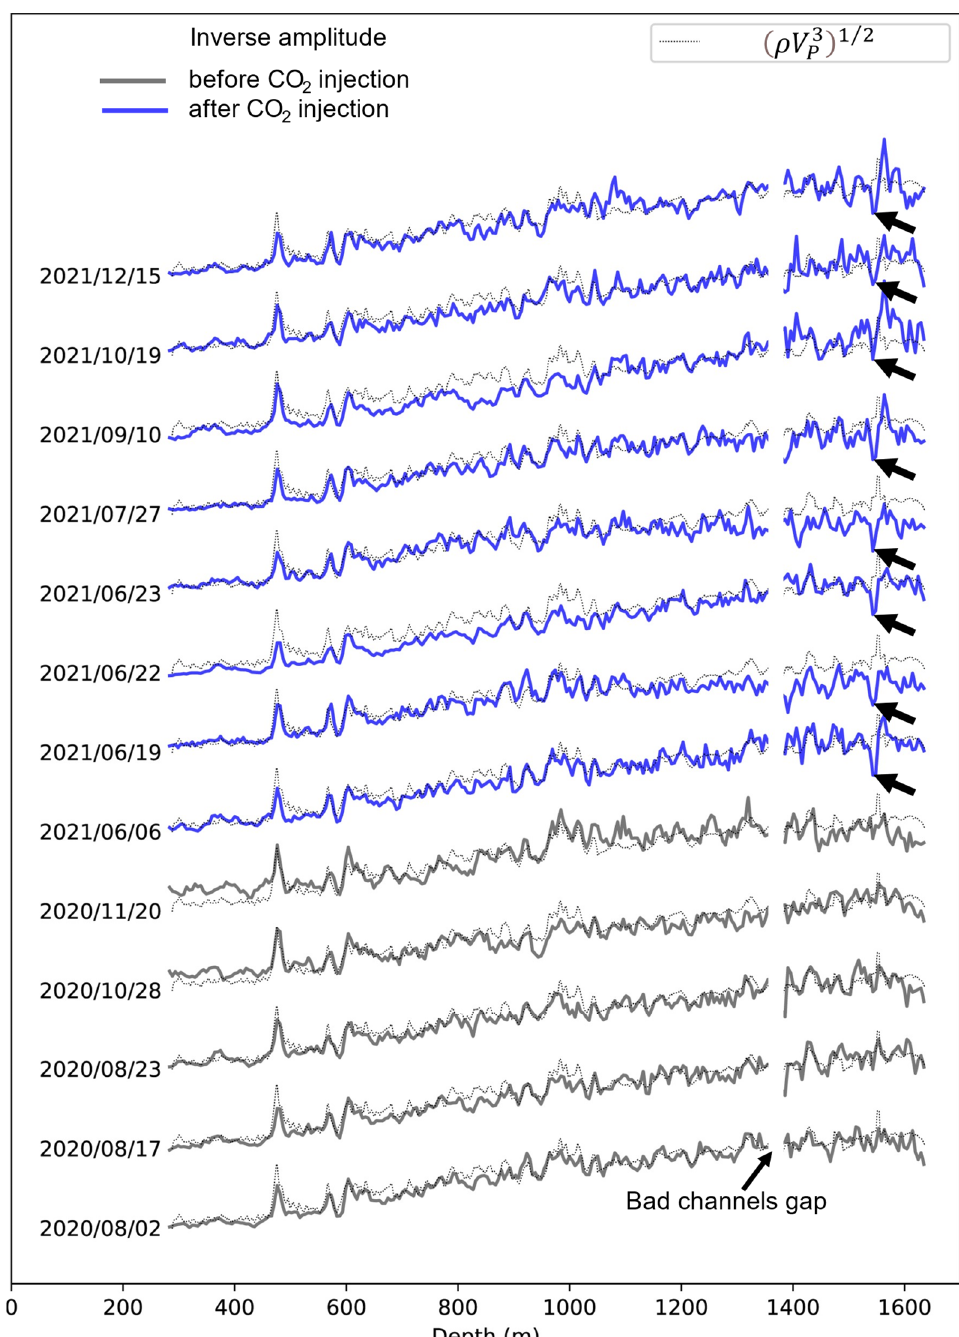
Figure 9. Inverse RMS amplitudes extracted from a series of CRC-3 DAS gathers of earthquakes before (black solid lines) and after (blue solid lines), plotted over DAS impedance (dotted lines) calculated from the CRC-3 well logs. Arrows indicate the amplitude an anomaly in the injection interval.